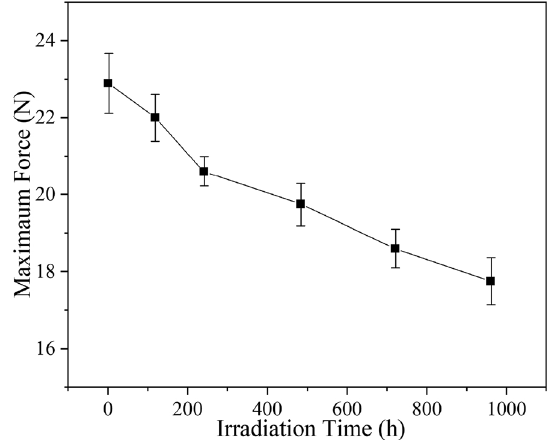
Figure 5 The pull force of the Sn50Pb49Sb1/Cu solder joints at various irradiation times